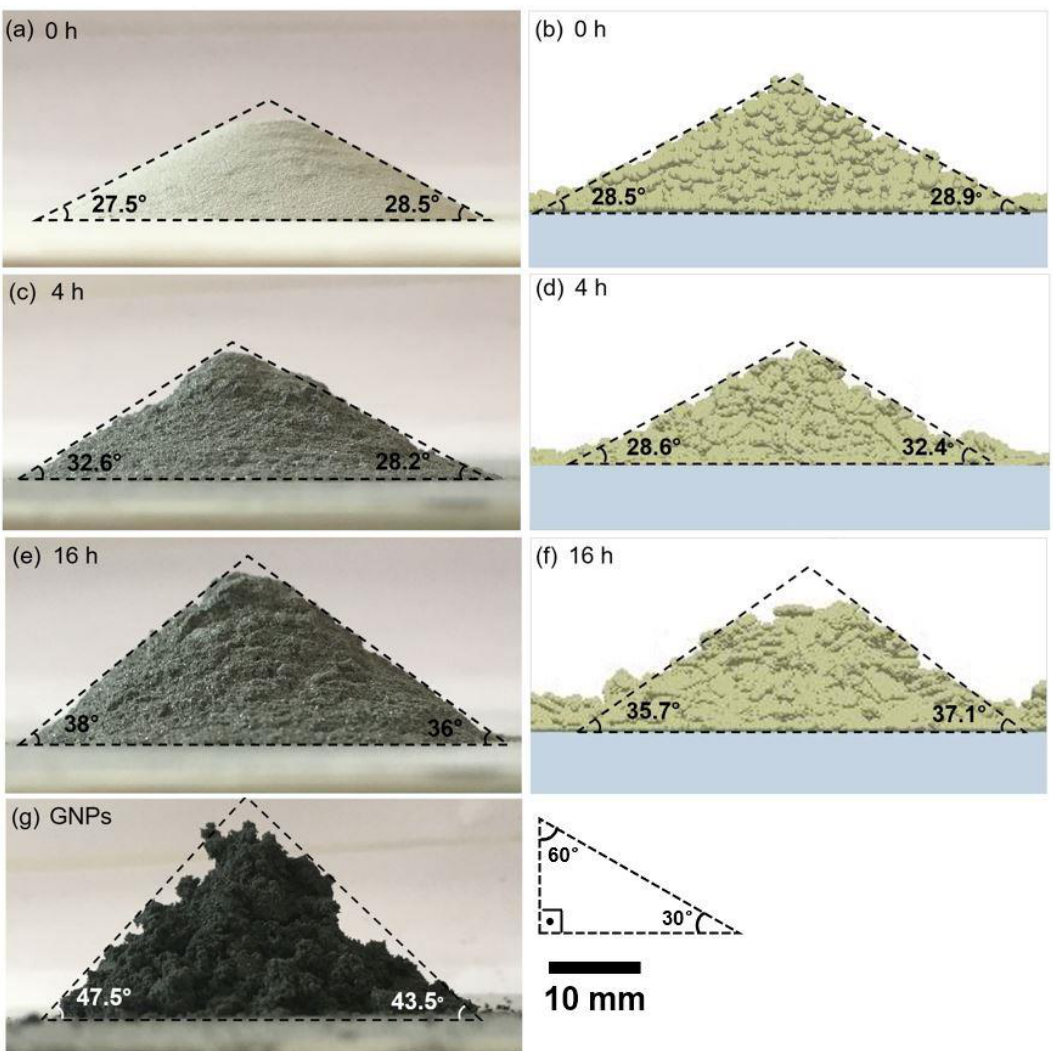
Figure 17. Reposed powder, showing GNPs, 0, 4 and 16 h milled alloy from ( a , c , e , g ) experimental work and ( b , d , f ) DEM simulation.